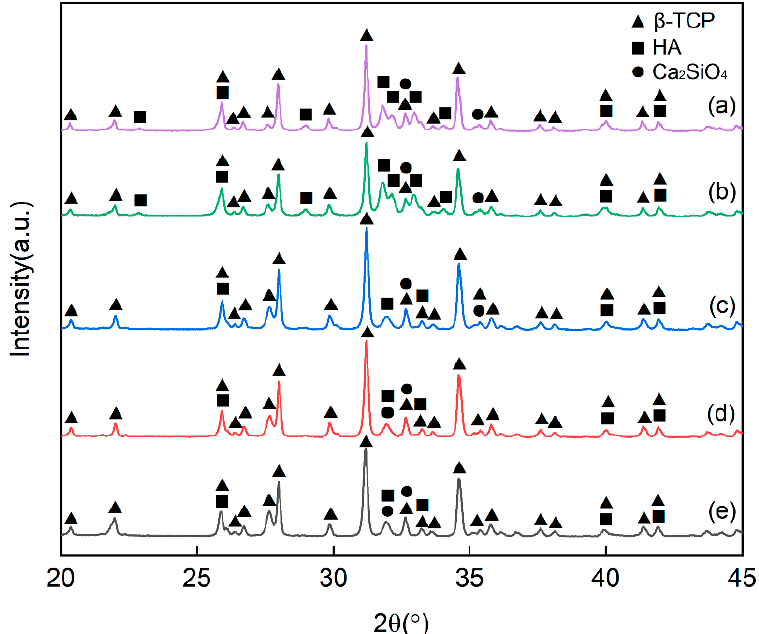
Figure 5. XRD patterns of ceramics with different sintering temperatures and different BAG contents: ( a )1000 ◦ C and 10 wt.% BAG; ( b )1000 ◦ C and 20 wt.% BAG; ( c )1100 ◦ C and 20 wt.% BAG; ( d )1200 ◦ C and 20 wt.% BAG; ( e )1300 ◦ C and 20 wt.%